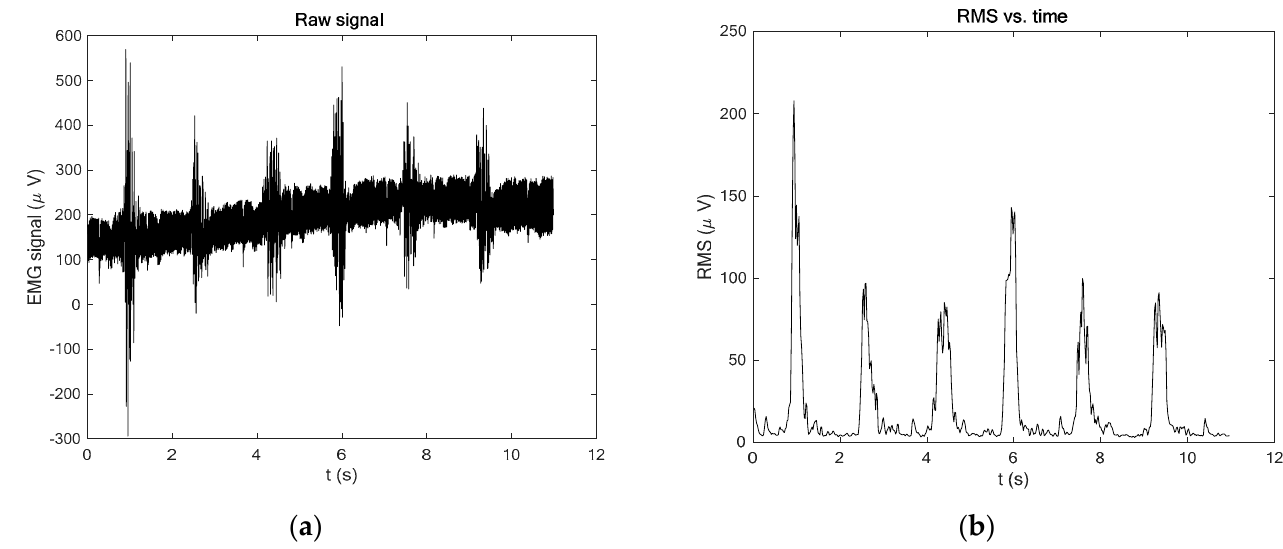
Figure 15. Example of analysis, ( a ) a raw EMG signal of the right abdominal muscle with high content of power line parasitic disturbances, ( b ) RMS-80/40 EMG signal of the right abdominal muscle with high content of power line parasitic disturbances, HP filter ( f c = 10 Hz), comb 40th order filter ( ∆ f = ±0.5 Hz)